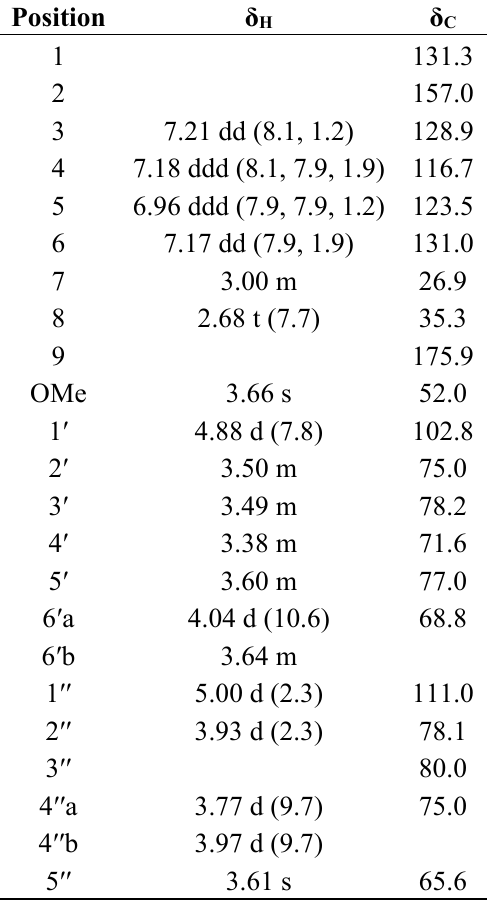
Table 1. 1 H-(400 MHz) and 13 C-NMR (100 MHz) Data of 1 in CD 3 OD. Position δ δ H